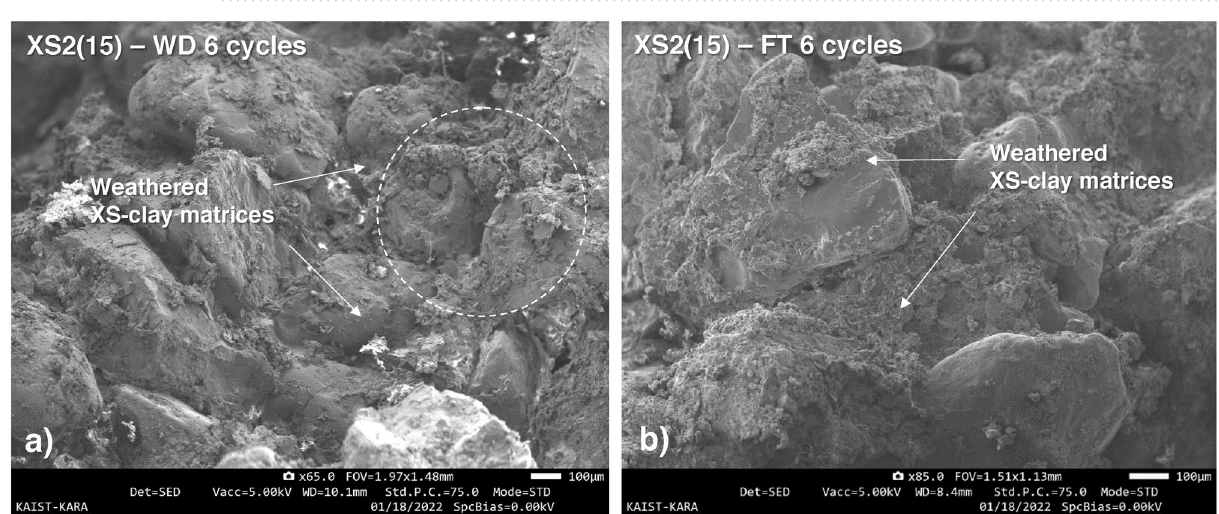
reduction ratio per cycle (F–T).